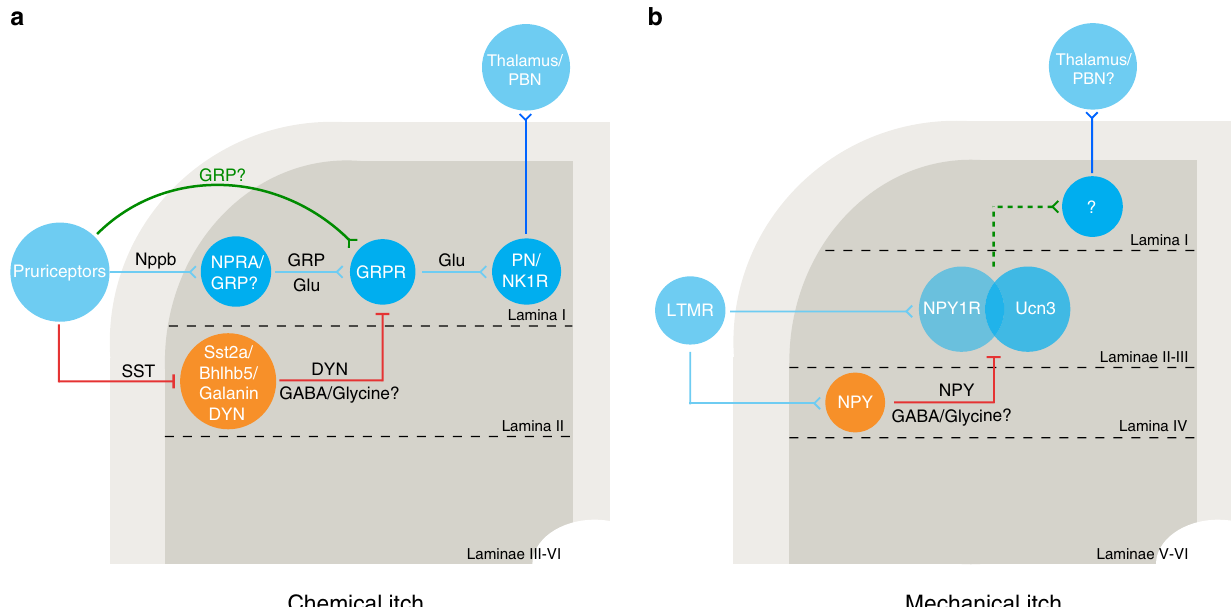
Fig. 1 Model of spinal circuits for chemical and mechanical itch. a When activated by chemical itch stimuli, the peripheral pruriceptors send the itch signals to spinal NPRA + neurons via Nppb, a primary itch transmitter. The secondary sensory (NPRA + or GRP + ) neurons then activate GRPR + neurons by releasing GRP, after which the itch signals are conveyed to the spinal projection neurons before reaching the thalamus or PBN for further processing. GRP was also proposed as another peripheral itch transmitter in some studies. The chemical itch circuit is gated by spinal inhibitory interneurons marked by Bhlhb5, which also coexpress DYN and Sst2a. These neurons are inhibited by peripheral-derived SST, while in turn inhibiting itch via the release of DYN and GABA/glycine. Spinal galanin + neurons also gate chemical itch processing by directly inhibiting the activity of GRPR + neurons, and the majority of these inhibitory neurons overlap with DYN/Bhlhb5 + neurons. b Light touch stimuli activate LTMRs to evoke mechanical itch, and the mechanical itch information is transmitted to spinal Ucn3 + neurons, a subset of which also express NPY1R, and these neurons are gated by spinal inhibitory NPY + neurons through NPY-NPY1R signaling as well as the inhibitory neurotransmitters GABA/glycine. PN projection neuron, LTMR low-threshold mechanoreceptor, Glu